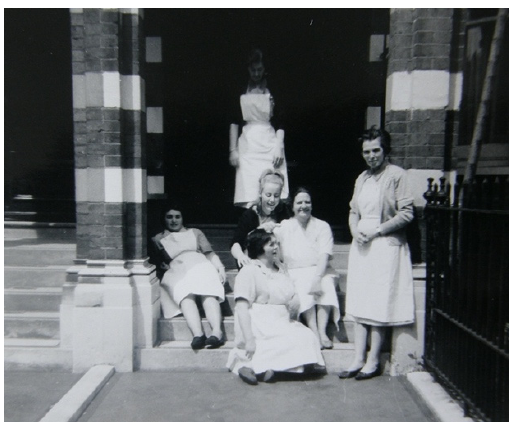
Figure 4. Virtudes and other workers at the nurses’ home at Bramham Gardens. Virtudes (e misterioso) Xes ú s Fraga (2020, p. 207). Reprinted with permission from Xes ú s Fraga (2020). Copyright 2020